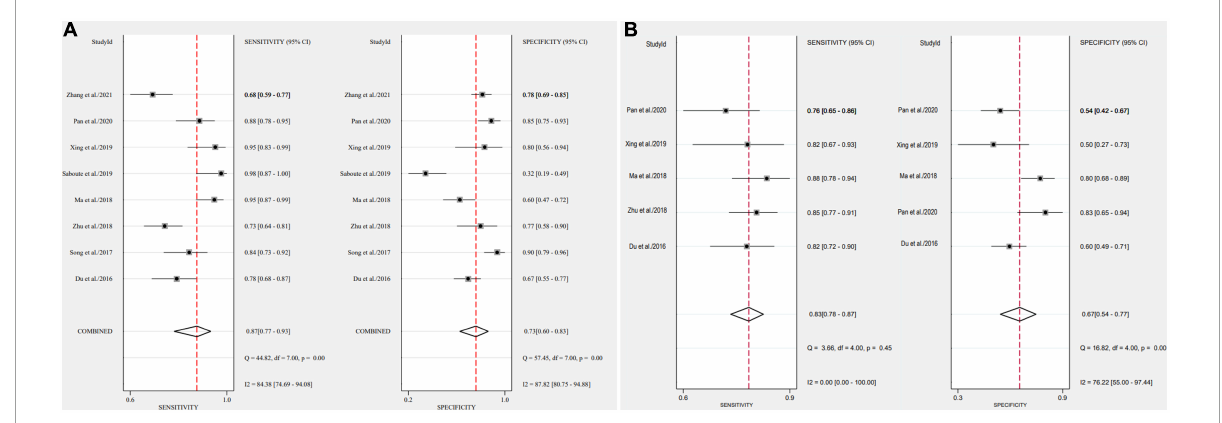
FIGURE4 Forest plots of pooled sensitivity and specificity of biomarkers aimed at sepsis (A) , interleukin 35 (IL-35) (B) , procalcitonin (PCT).